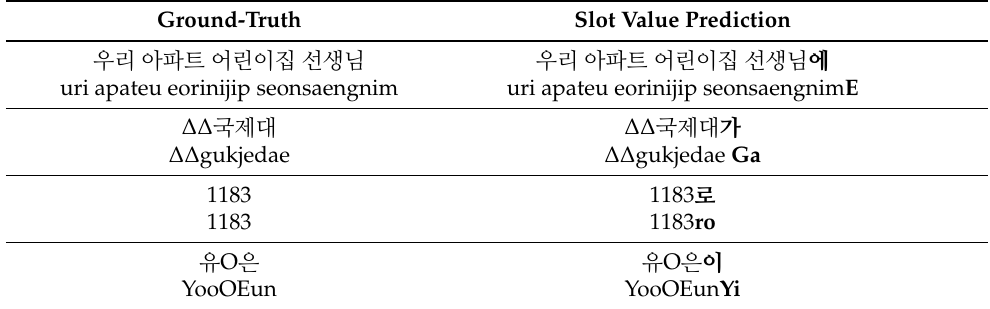
Table 8. Examples for prediction including postposition. Bold denotes the postposition in each